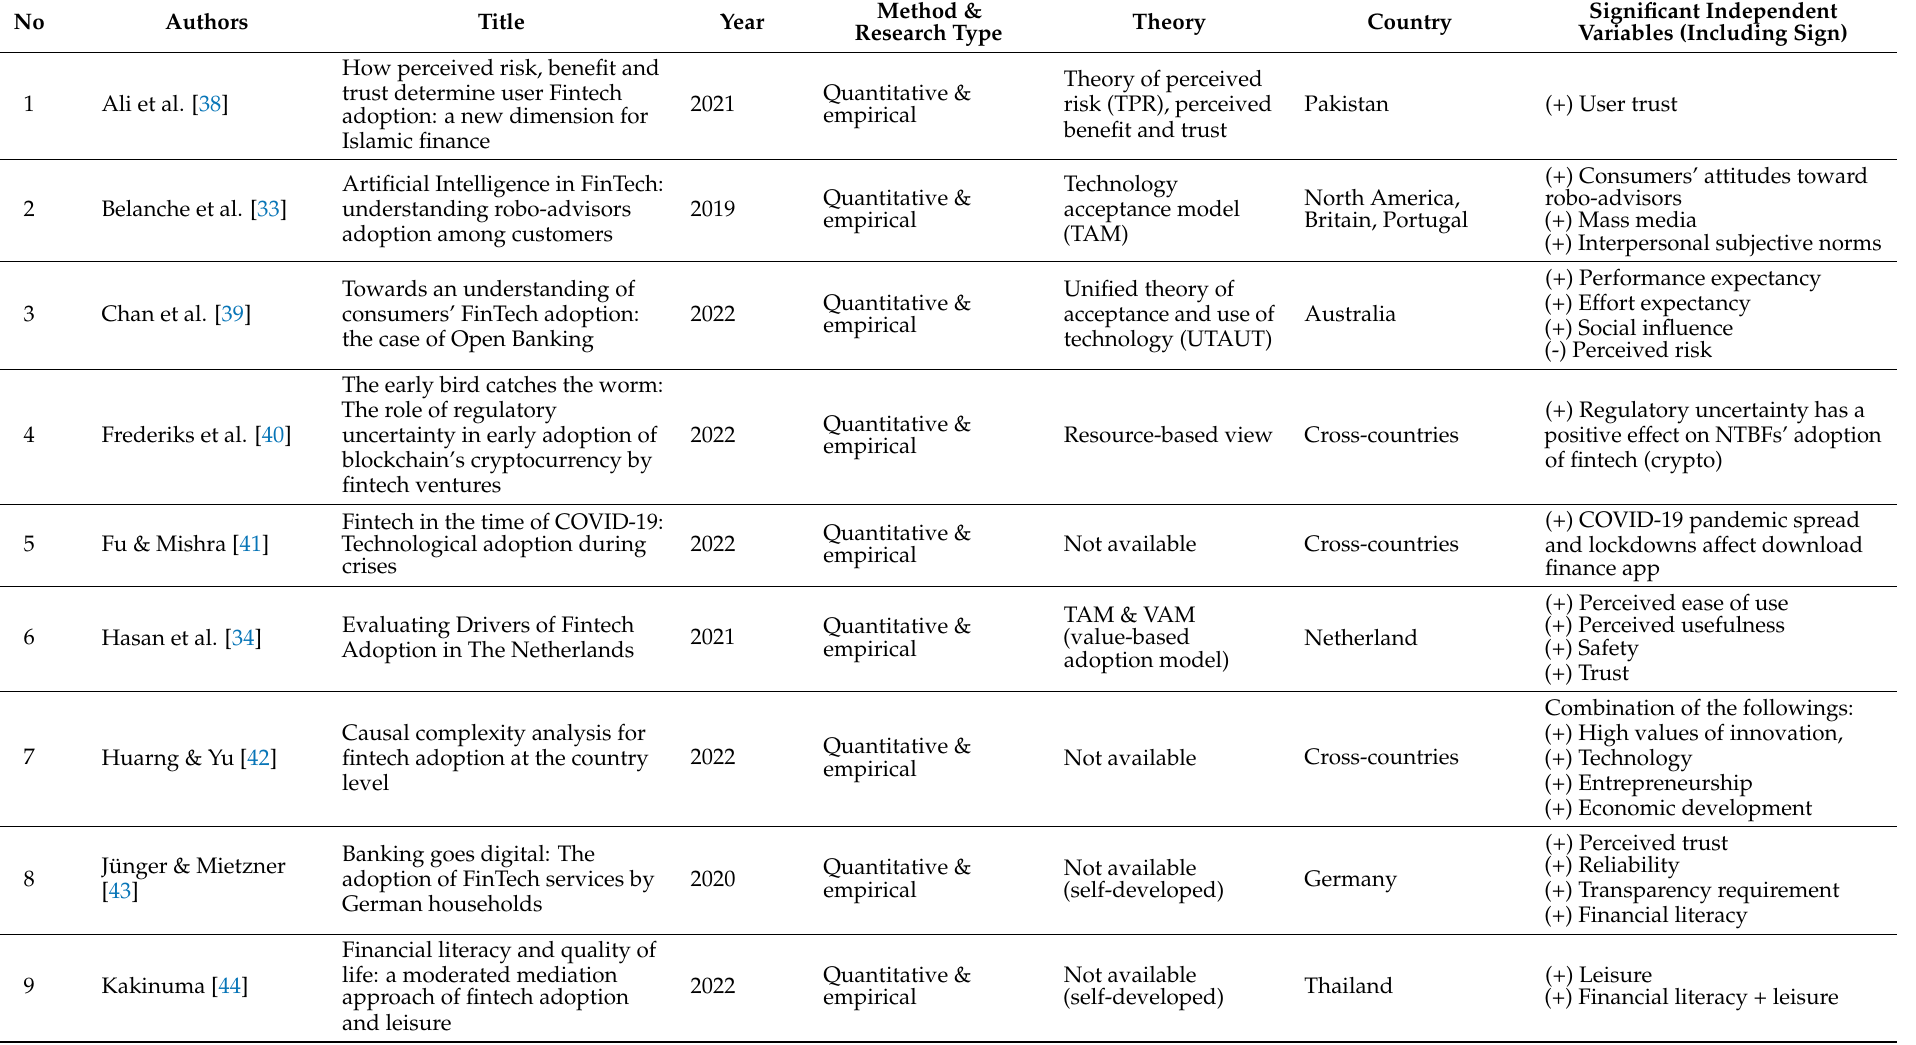
Table 2. Papers on fintech